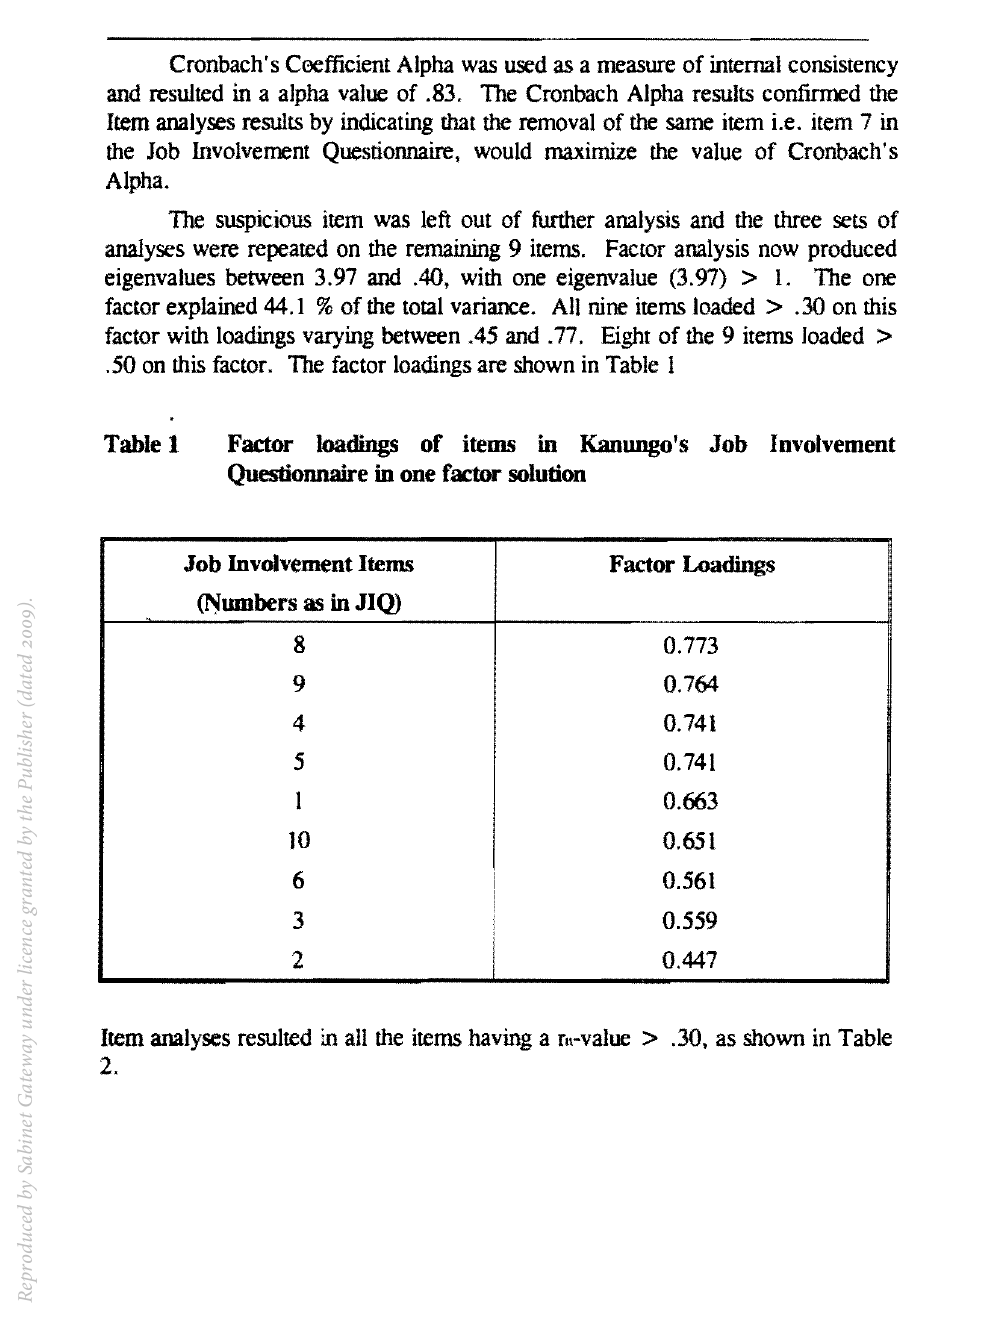
Factor loadings of items in Kanungo's Job Involvement Questionnaire in one factor